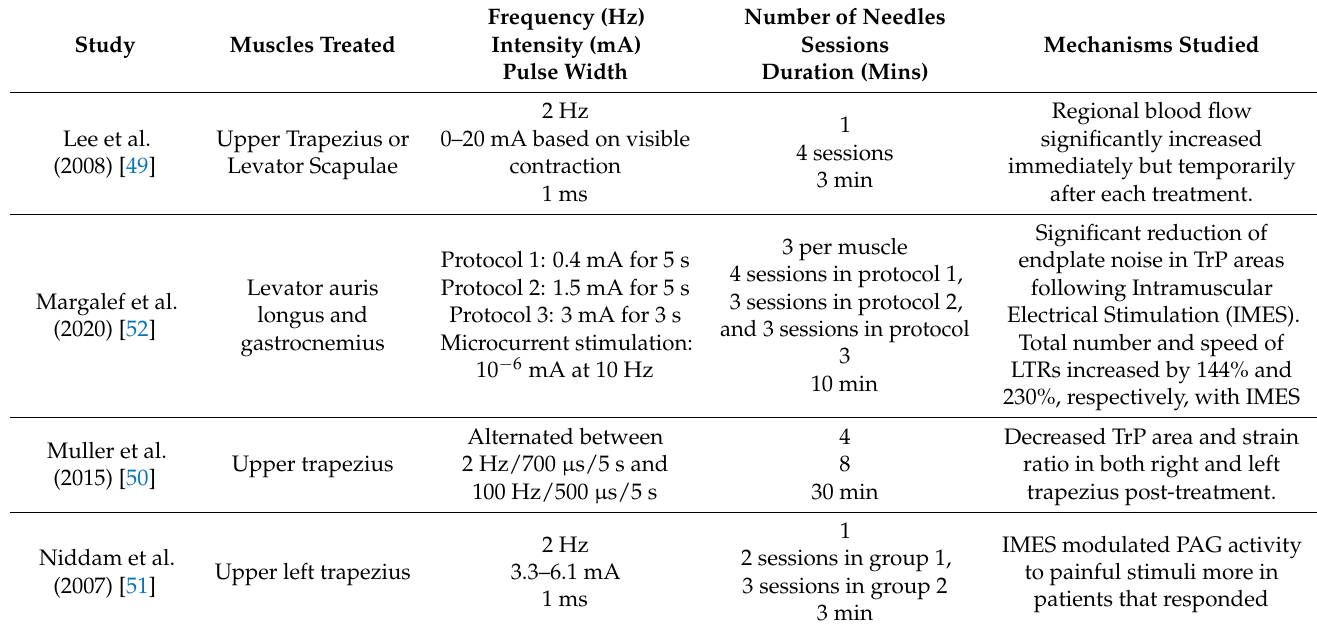
Table 4. Summary of individual IMES parameters and mechanisms